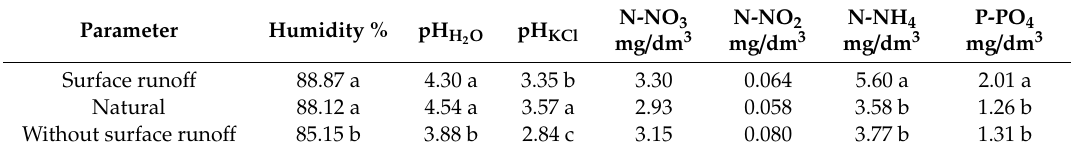
Table 5. Characteristics of peat soil research areas on natural habitats (SD1-2) subjected to surface runo ff s (T1 and Z1) and not subjected to surface runo ff (S1-2, R1-3, ZB1-3, N1-3 and Z1).